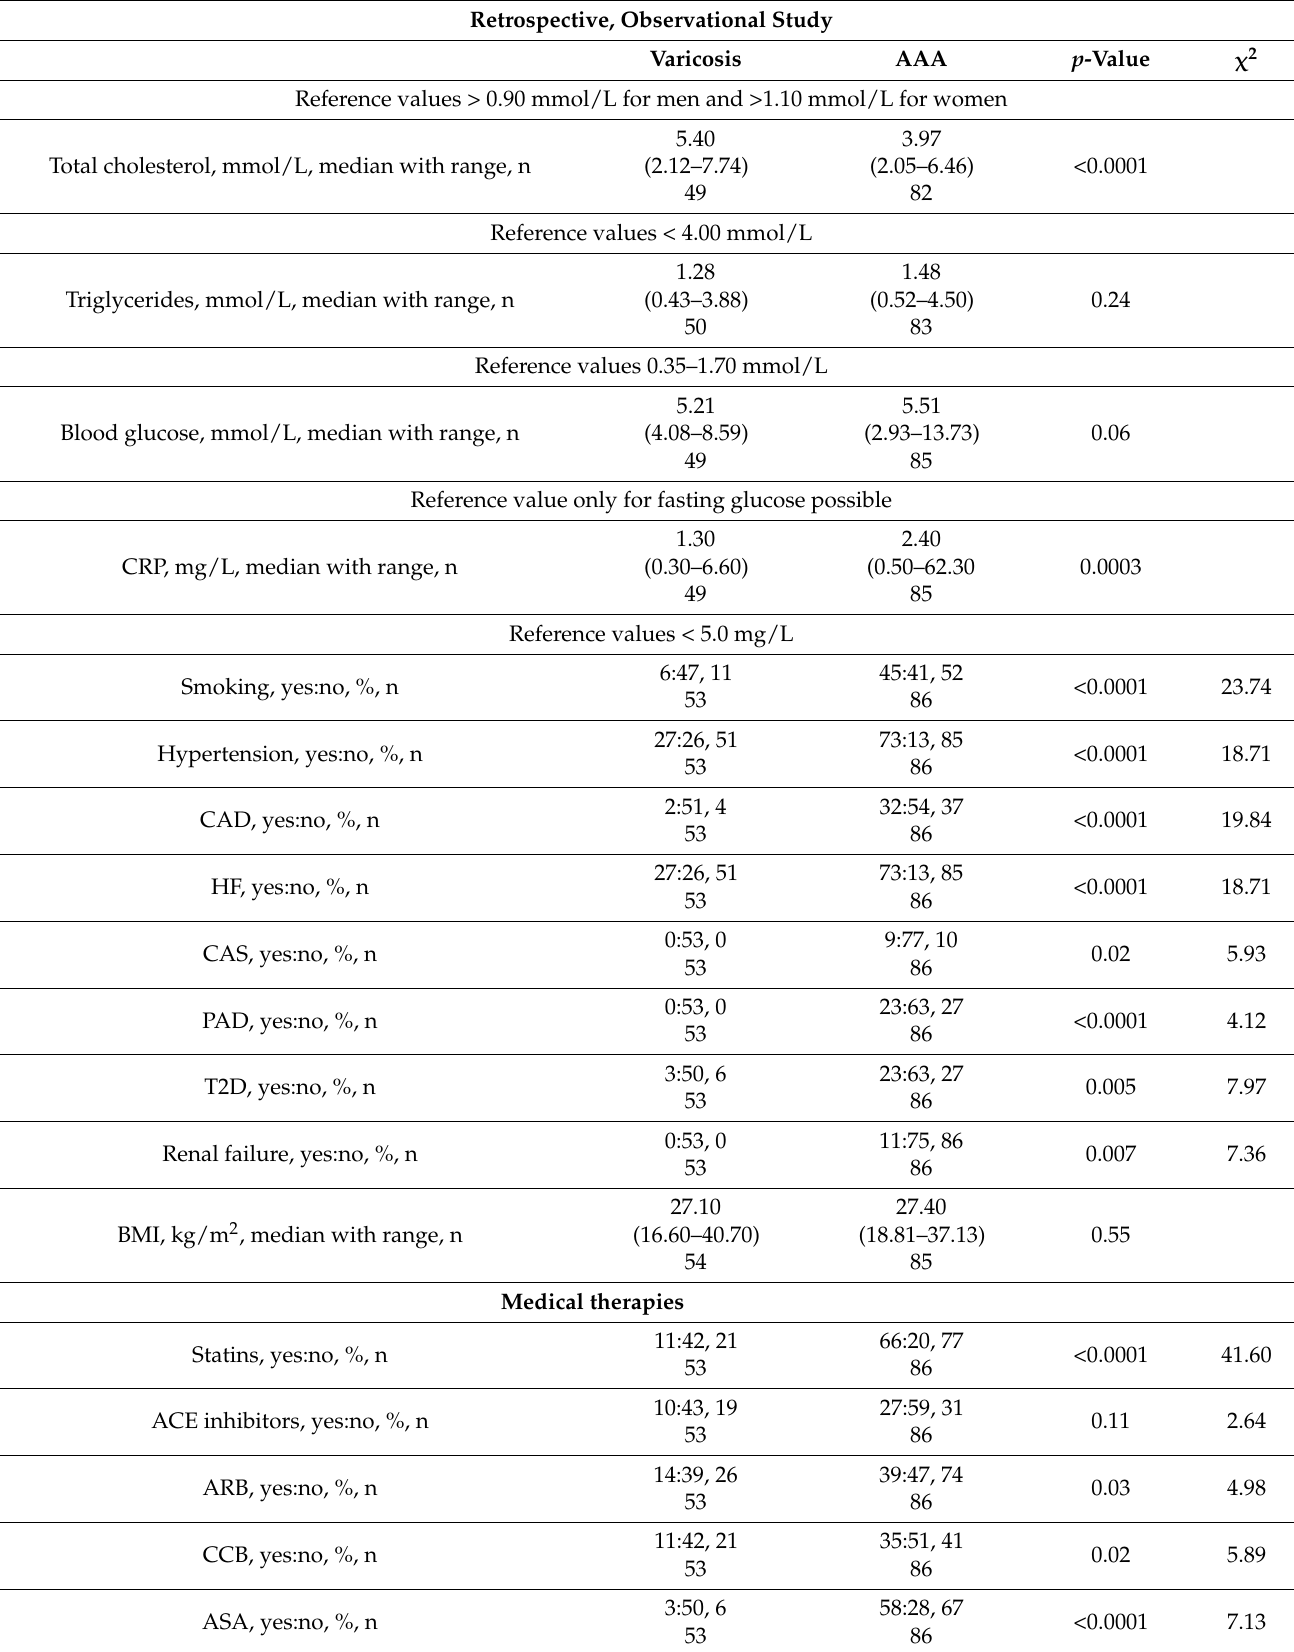
Table 2. Cont. Retrospective, Observational